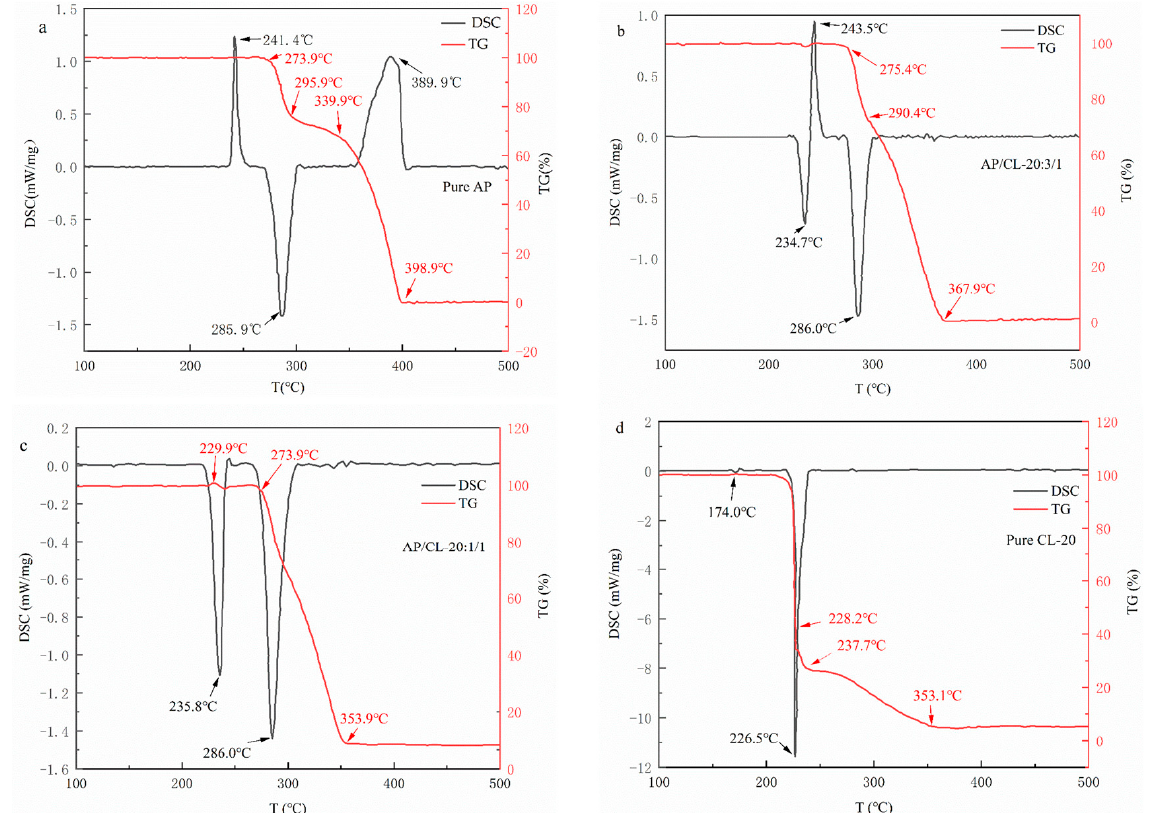
Figure 2. TG-DSC curves for four different samples: ( a ) Pure AP; ( b ) 75% AP/25% CL-20; ( c ) 50% AP/50% CL-20; and ( d ) Pure CL-20. Ar was used as protective gas and the flow rate was 100 mL·min − 1 . The temperature ranges from room temperature to 600 °C, with a heating rate of 5 °C·min − 1 . Approximately 1 mg of the sample was loaded for each test.